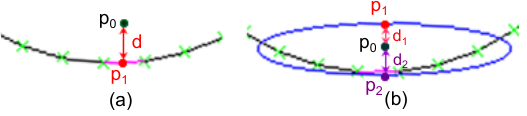
(a) Distance evaluation using the edge from the mesh. (b) When dealing with conic curves, it is necessary to find the correct conic segment from which the distance will be calculated. In this case, although d 1 < d 2 , the correct distance to be used is d 2 . p 0